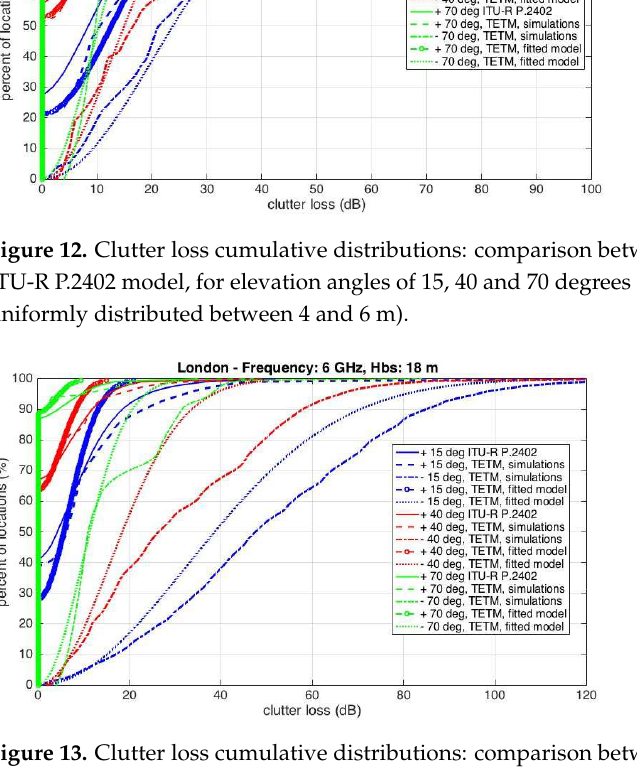
Figure 14. Clutter loss cumulative distributions: comparison between the proposed model and the ITU-R P.2402 model, for elevation angles of 15, 40 and 70 degrees in Melbourne (base station height fixed at 18 m). 7. Model Validation The commercial ray tracer SIRADEL© [19] is used to validate the proposed model. The chosen urban environment for validation is a square area with a lateral dimension of 1.2 km in the city of Hong Kong, which is deemed appropriate due to the high building density and the scarcity of vegetation. The statistics of buildings are obtained as detailed in Section 3 from the available SIRADEL© data by deploying 500 survey points. CDF